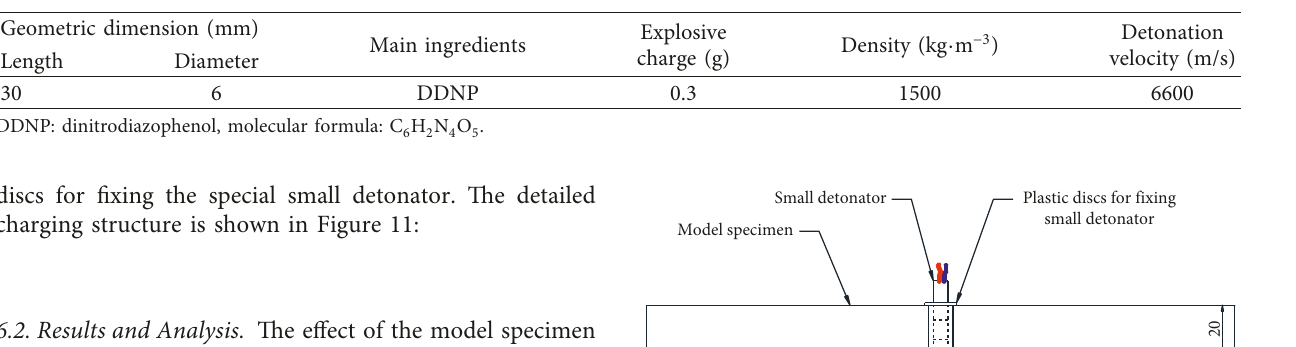
Table 5: Explosive physical parameters of the special small detonator.